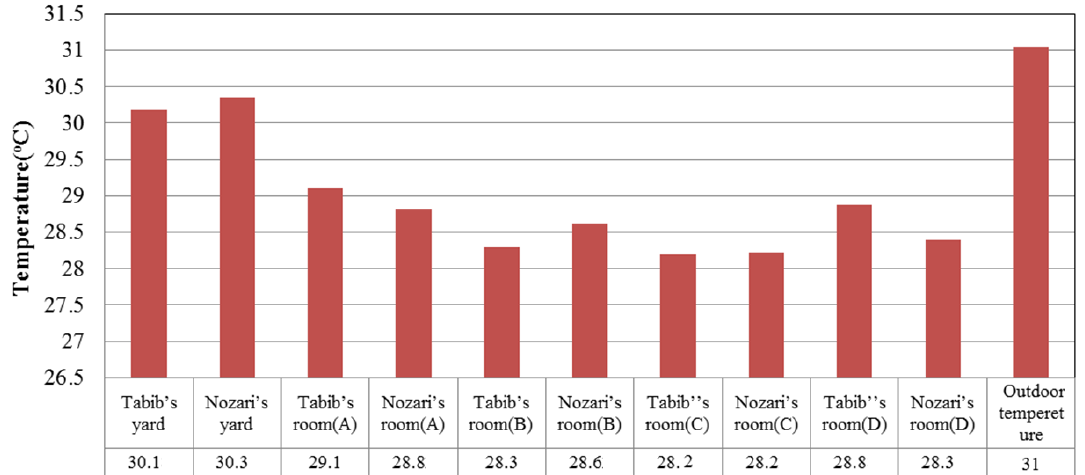
Figure 12. Average temperature of spaces during test days (August 30 and September 1, 4, 16, 23, 27, and 30, 2016).